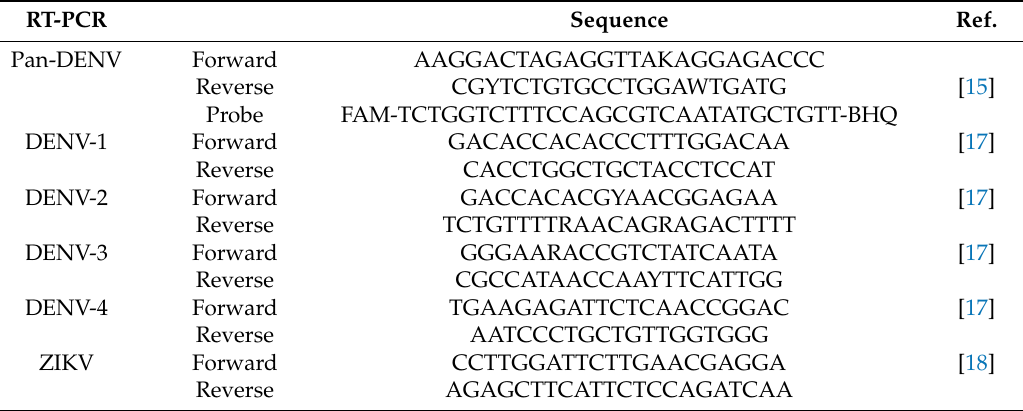
Table 1. Primers used for pan-dengue virus (DENV), DENV serotype-specific and Zika virus